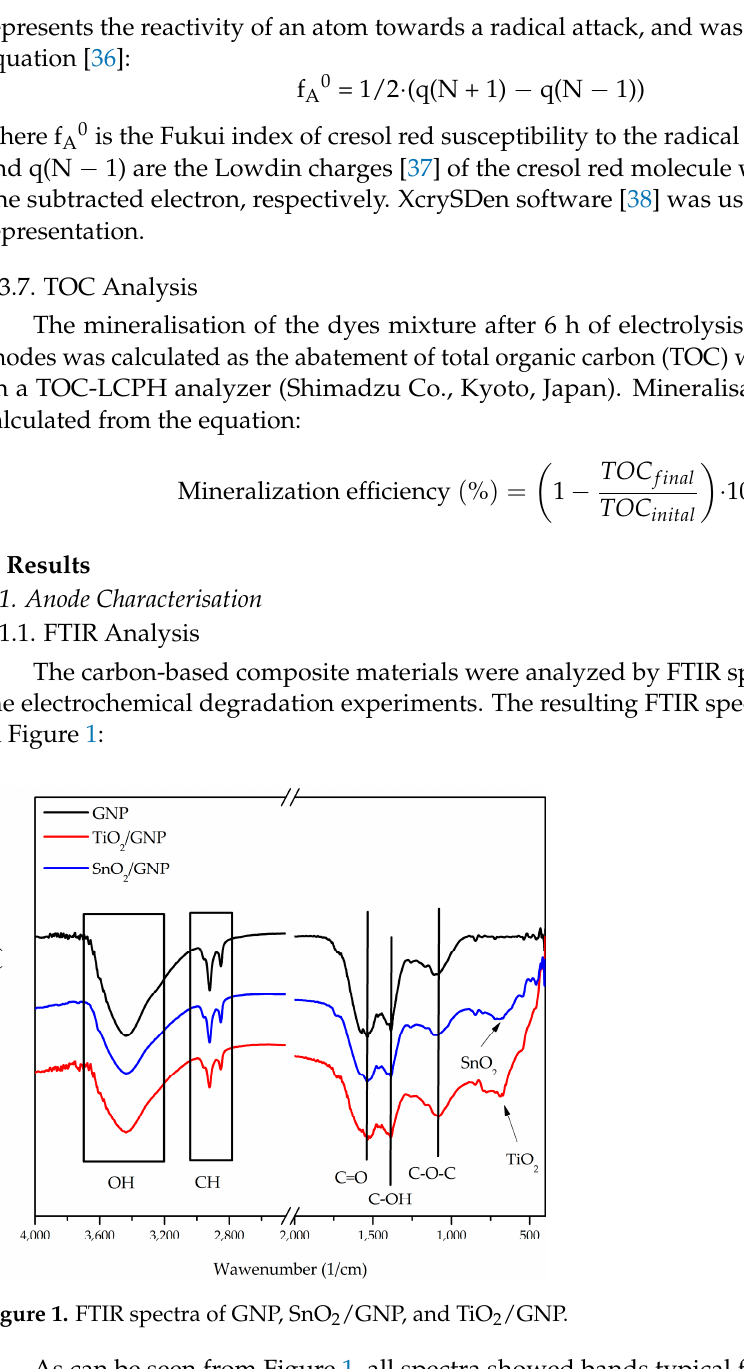
2 /GNP, and TiO 2